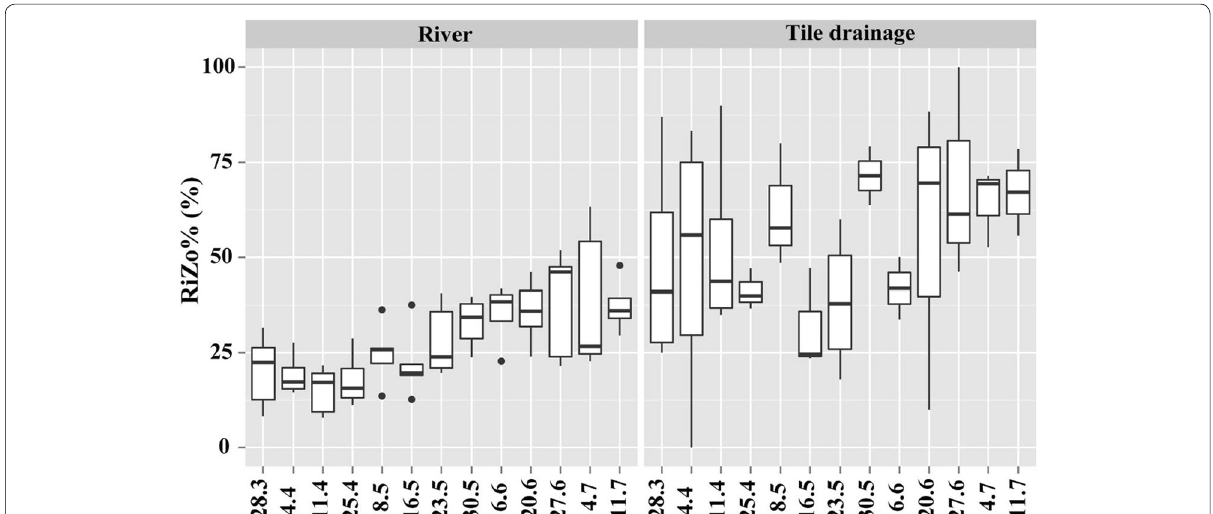
Fig. 6 Temporal variations of RiZo% at river (Ri) and tile drainage (TD) sites. Boxes show interquartile ranges (25th and 75th percentiles), middle lines are medians, whiskers are non‑outlier ranges beyond the boxes, and dots are outliers. Other diversity indices performed similarly (not shown)